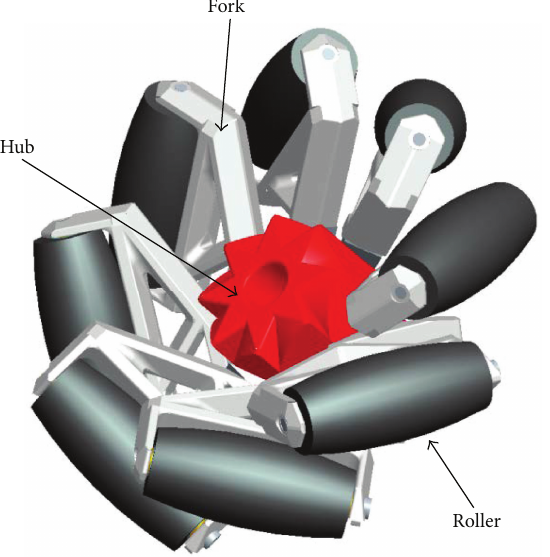
Figure 1: Schematic of the proposed mecanum wheel and its